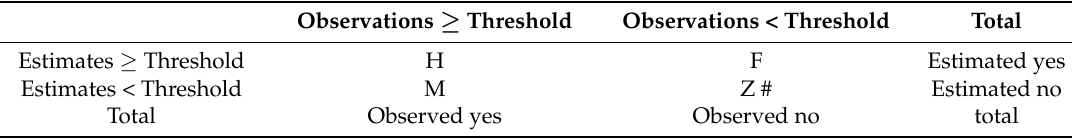
Table 2. Contingency table between the rain gauge observations and satellite estimates. Observations ≥ Threshold Observations < Threshold Total Estimates ≥ Threshold H F Estimated yes Estimates < Threshold M Z # Estimated no Total Observed yes Observed no total # Z stands for correct estimation of no